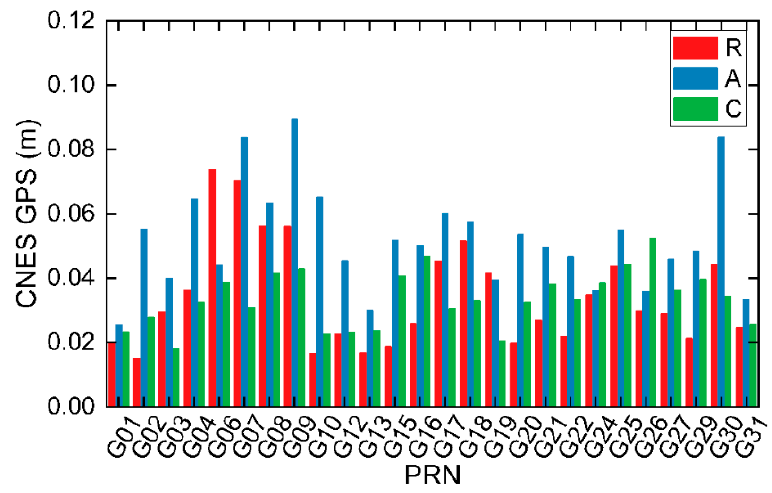
Figure 5. RMSEs of the PPP-B2b orbits for GPS satellites.